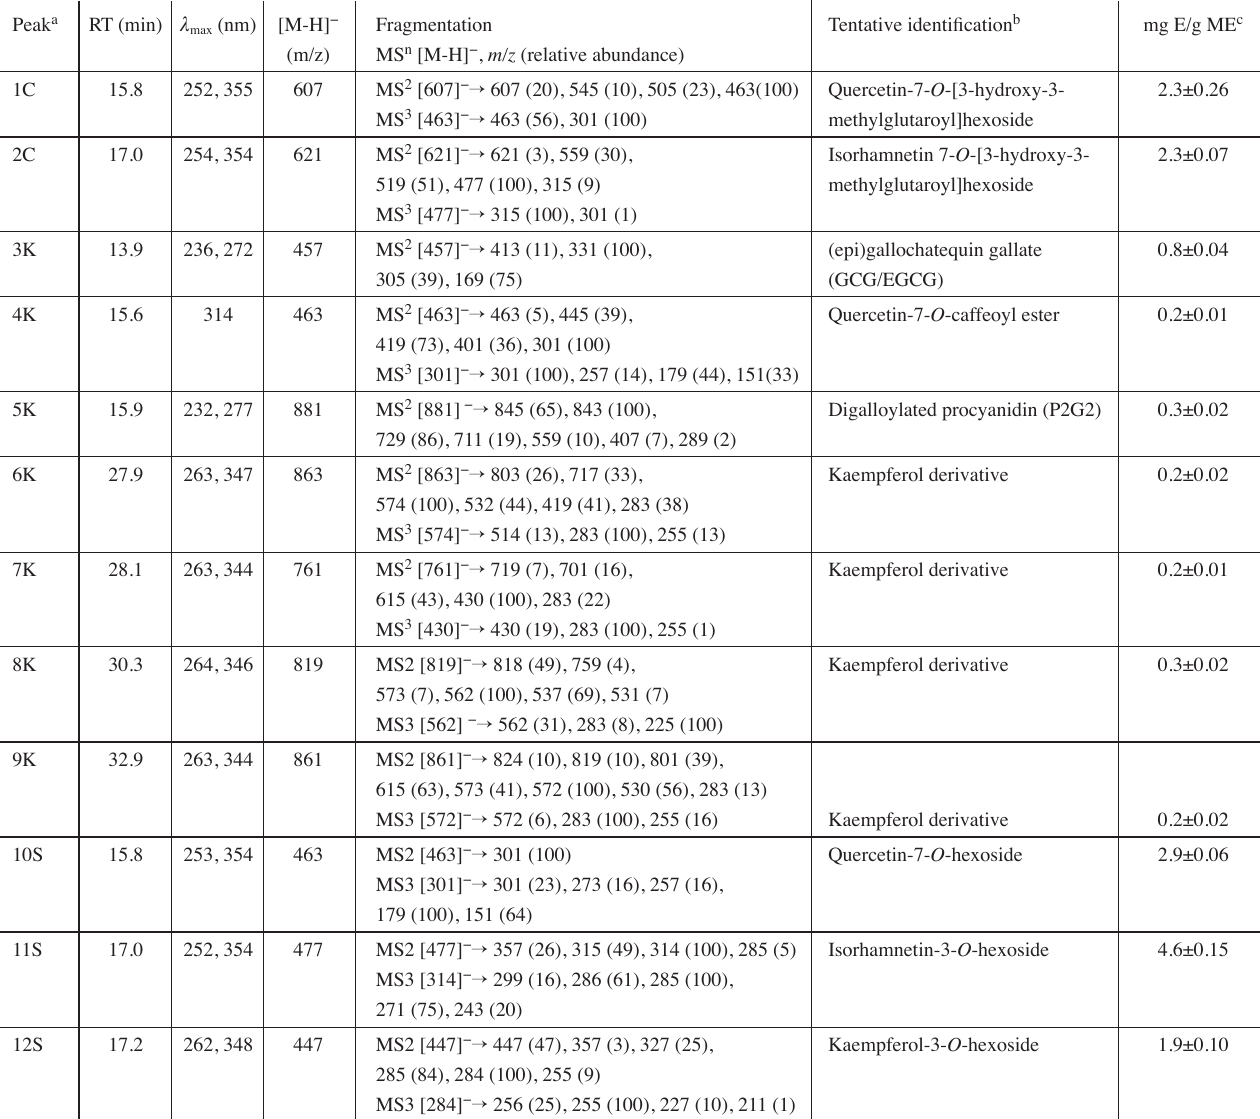
Tab. 2: HPLC-DAD-ESI-MS n data and content of phenolic of Echeveria methanol extracts